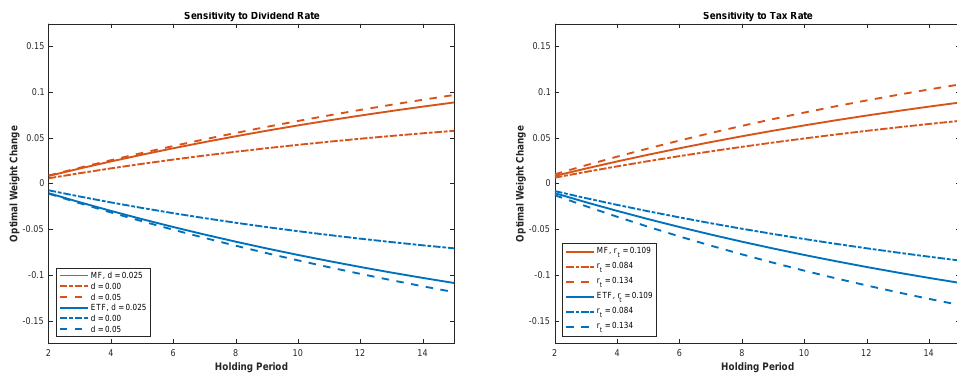
Figure 2. Sensitivity of funds’ optimal weight change given parameter